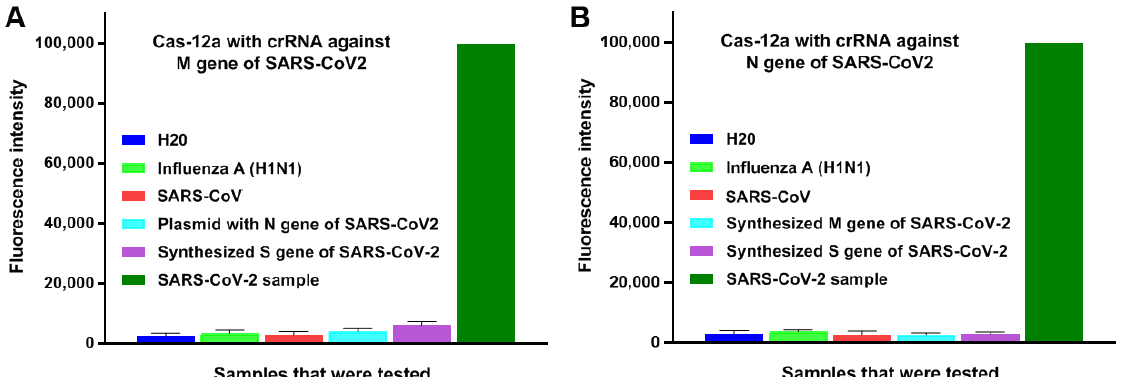
assay with crRNA against M gene of SARS-CoV-2 specifically detected SARS-CoV-2. ( B ). The assay with crRNA against N gene of SARS-CoV-2 particularly detected